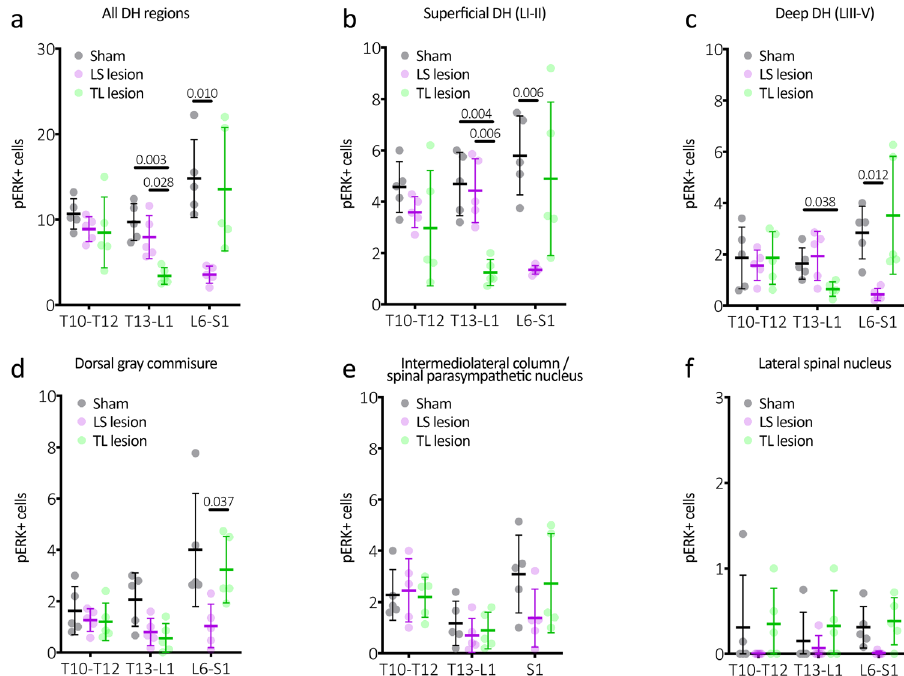
Fig. 8 Subregion analysis of distension-evoked pERK expression in the spinal cord dorsal horn. a Average counts from all dorsal horn regions. These data are identical to that shown in Fig. 5. b Counts from the super fi cial dorsal horn (LI – II), which typically showed the largest numbers of pERK-IR nerve cell bodies of all subregions analysed. Here it can be seen that the LS lesioned mice have signi fi cantly lower numbers of pERK-IR cells than the other groups at the level of the lesion. Interestingly, the TL-lesioned mice showed signi fi cantly fewer pERK-IR cells at the levels of T13-L1, compared to control. This suggests some involvement of the thoracolumbar pathways to distal colonic distension, despite lacking a detectable contribution to the VMR. c Counts from the deep dorsal horn (LIII-V). This shows a similar general pattern to that seen in the super fi cial layers, with lower cell counts. d Counts from the dorsal grey commissure, also showing a similar pattern to super fi cial and deep layers. Here, only counts at L6-S1 were signi fi cantly reduced in LS lesioned mice compared to TL-lesioned mice. e Counts from the intermediolateral column or spinal parasympathetic nucleus, showing no statistically signi fi cant differences between groups. f Counts from the lateral spinal nucleus were very low and showed no signi fi cant differences between groups. P values refer to two-way, repeated measures ANOVA, Tukey post-hoc comparison tests. Individual data points represent the mean number of pERK-IR neurons per section per mouse. All error bars represent mean ± SD, individual markers represent individual animal